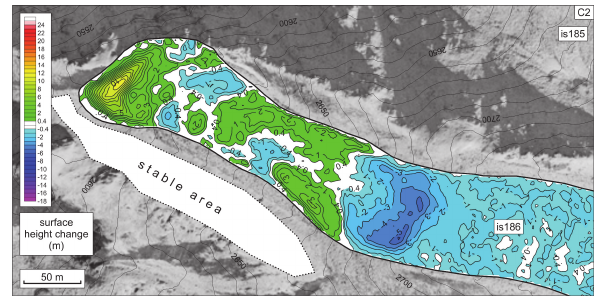
Figure 12. Surface height change